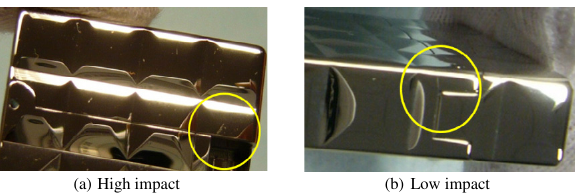
Fig. 8. Law of similarity: anomaly impact.